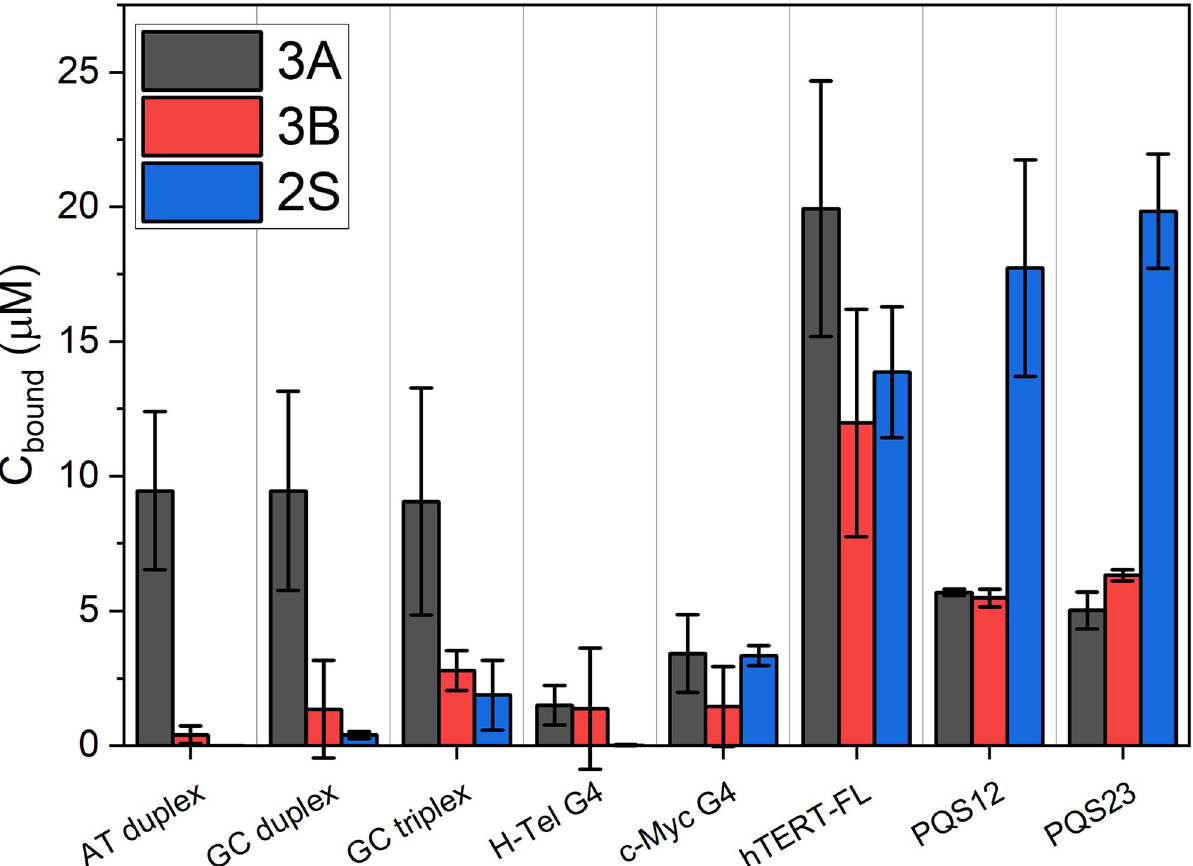
Fig 3. Competition dialysis results. The bound concentration (C bound ) is the concentration of compound in the dialysis well less that of the “free” compound concentration in the dialysate. Bars and whiskers represent average and standard deviation about the mean from the average of duplicate measurements made on four independent